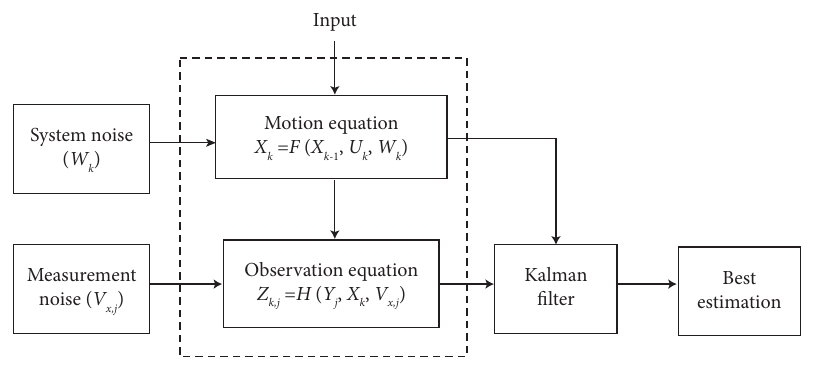
Figure 5: Transformation between world coordinate system ( O system ( o ′ y ′ x ′ ) , and image plane coordinate system ( oyx ) .